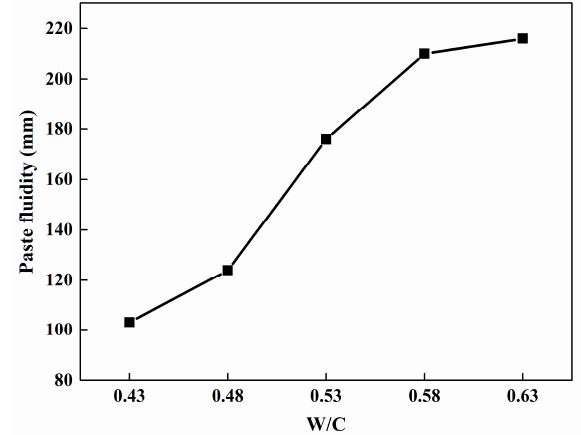
ff ect of water–cement ratio on pastes Figure 3. Effect of water–cement ratio on pastes fluidity. Figure 3. E